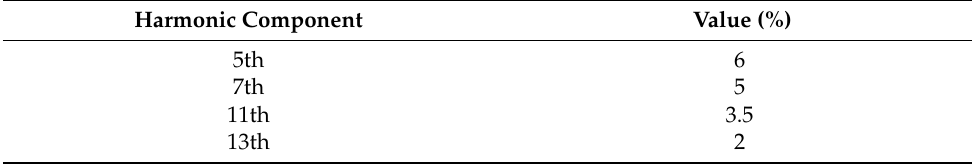
Table 2. Harmonic voltage profile under